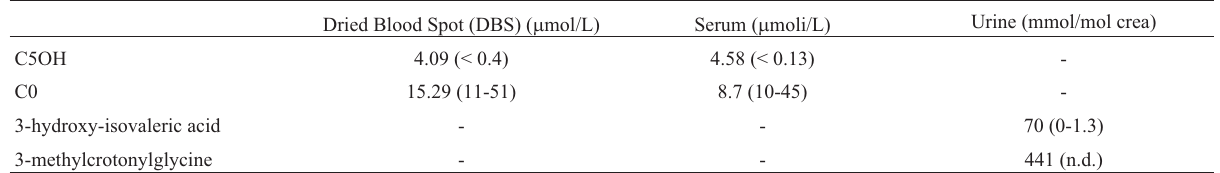
Table1 -Biomarkersfoundalteredintheanalyzedpatient.ThesewerequantifiedbyLCMSMSanalysisondriedbloodspotandserum,byGCMSanaly- sis in